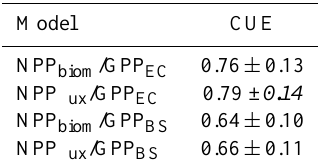
Table 7. The four approaches used to assess the CUE ( ± se) of the studied apple orchard. (average = 0.71 ±